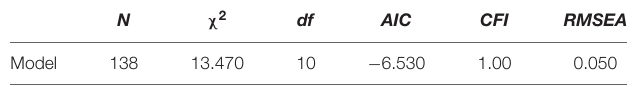
TABLE 4 | Fit indices for the EQS model. N χ 2 df AIC CFI RMSEA